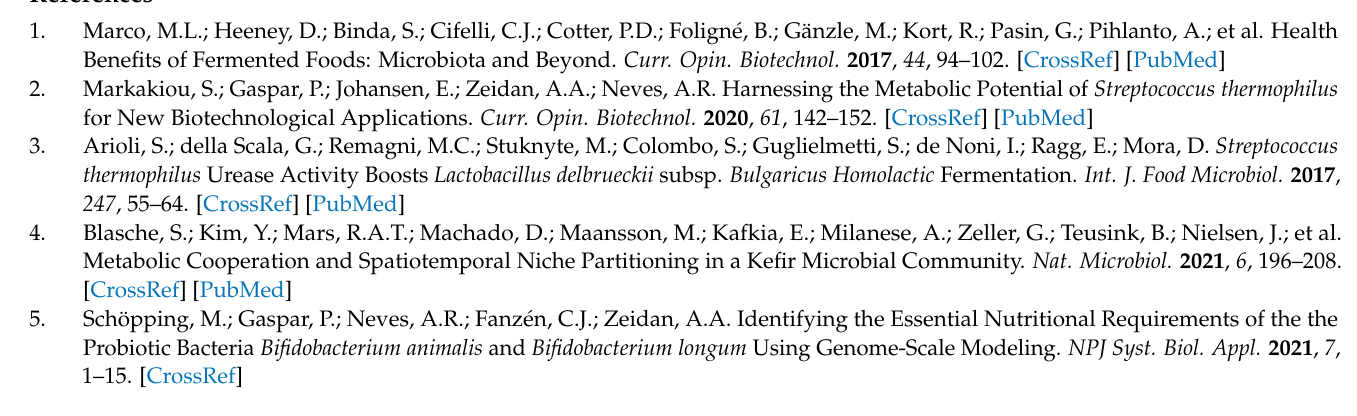
concentrations in LB.1 culture; Figure S8: Correlations between flow cytometric data and cell dry weight; Figure S9: Enumeration of total cell events; Figure S10: Classification of flow cytometric data; Figure S11: Code for support vector machine (SVM) training; Figure S12: Amino acid concentrations in LB.1 culture; Figure S13: Fitted Gaussian model for aspartate; Figure S14: Fitted Gaussian model for glutamate; Figure S15: Fitted Gaussian model for serine; Figure S16: Fitted Gaussian model for histidine; Figure S17: Fitted Gaussian model for glycine; Figure S18: Fitted Gaussian model for threonine; Figure S19: Fitted Gaussian model for arginine; Figure S20: Fitted Gaussian model for alanine; Figure S21: Fitted Gaussian model for tyrosine; Figure S22: Fitted Gaussian model for valine; Figure S23: Fitted Gaussian model for tryptophan; Figure S24: Fitted Gaussian model for phenylalanine; Figure S25: Fitted Gaussian model for isoleucine; Figure S26: Fitted Gaussian model for leucine; Figure S27: Fitted Gaussian model for